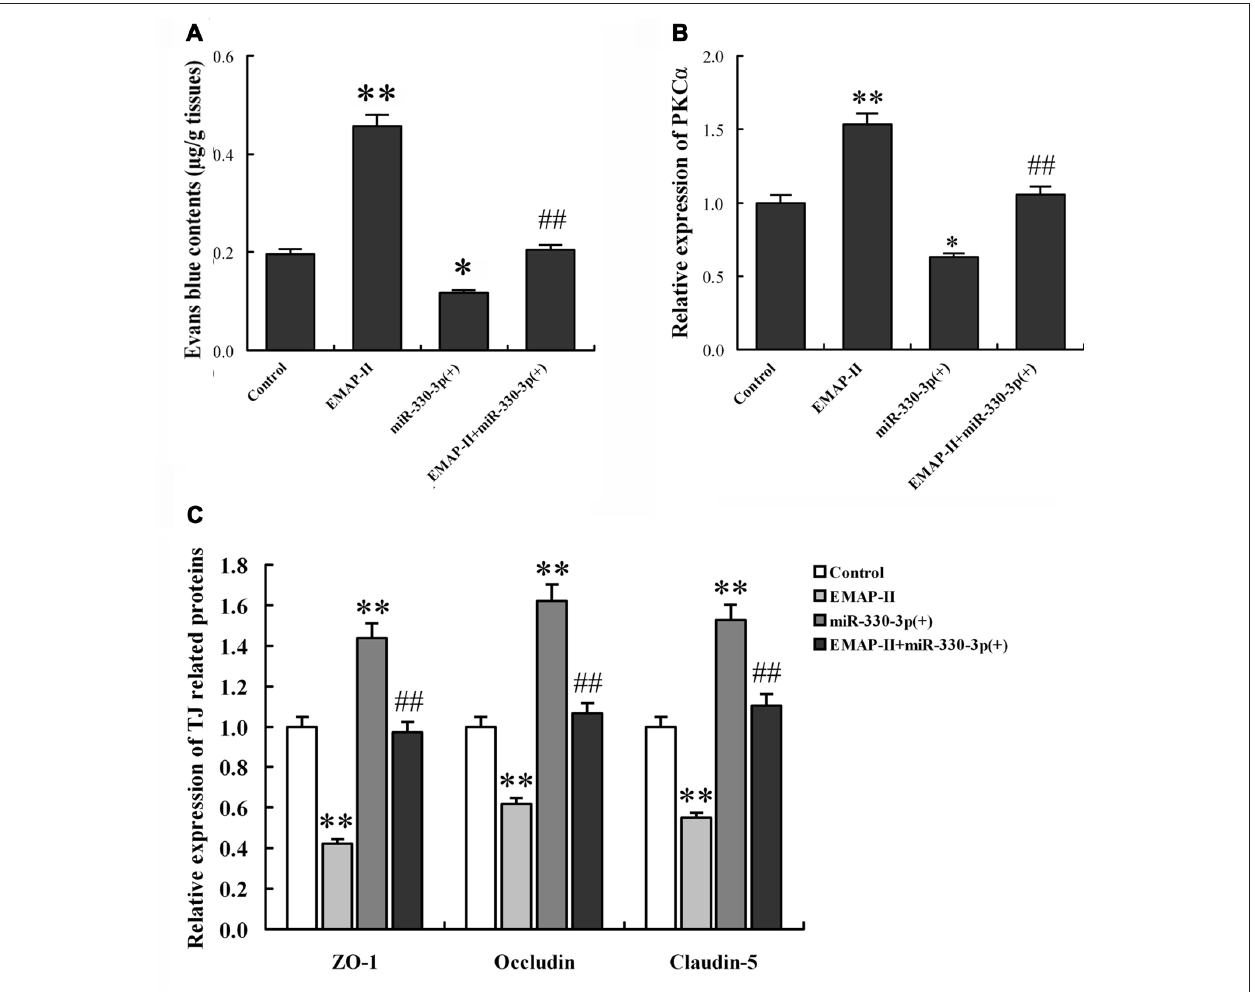
FIGURE 8 | EMAP-II increased the BTB permeability in vivo via down-regulating miR-330-3p orthotopic xenograft model. (A) Contents of evans blue (EB) in tumor-bearing brain after EMAP-II and miR-330-3p lentivirus injection. The expression levels of PKC α (B) and TJ proteins (C) in tumor microvessel segments were detected by qRT-PCR. Values are means ± SD ( n = 5, each). ∗ P < 0.05, ∗∗ P < 0.01 vs. control group; ## P < 0.01 vs. EMAP-II